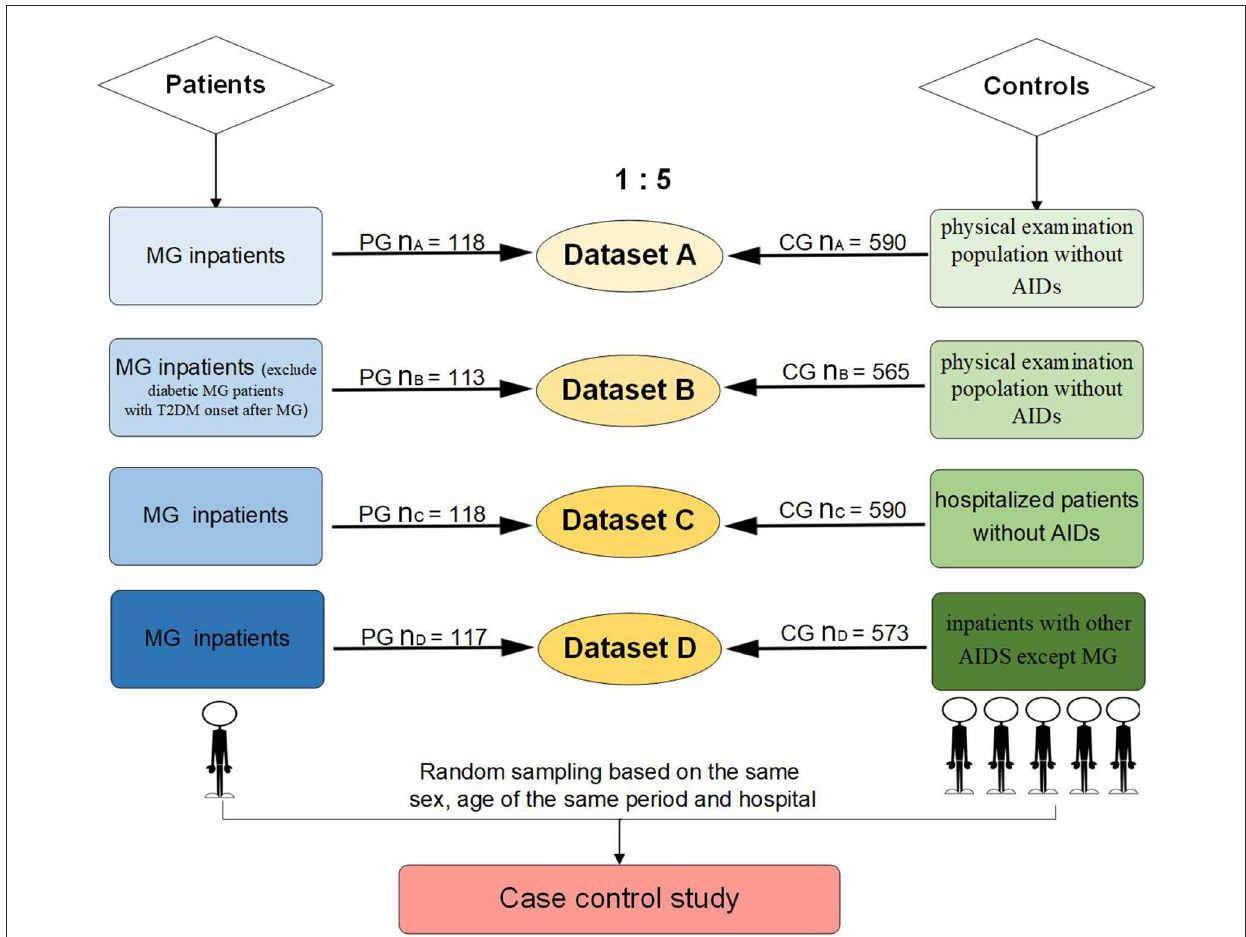
FIGURE1 Flowchart of MG patients and controls inclusion (PG, patient group; CG, control